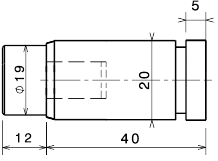
Figure 13. The projectile for the dynamic tensile test and the Dynamic shear test.